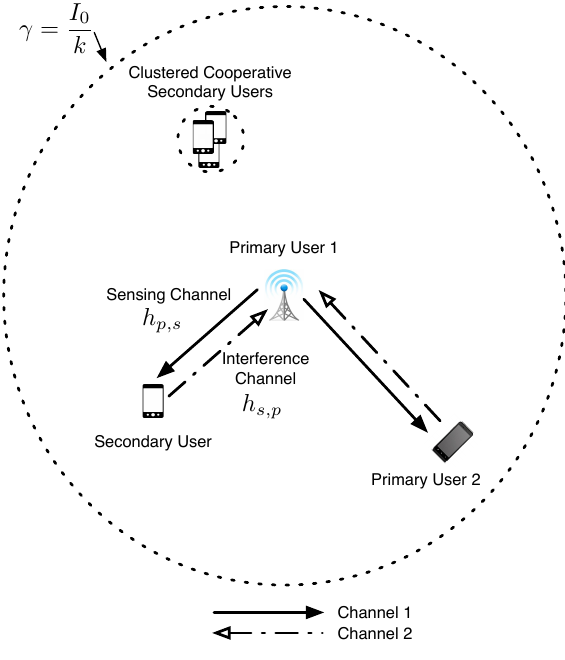
Figure 1. The system